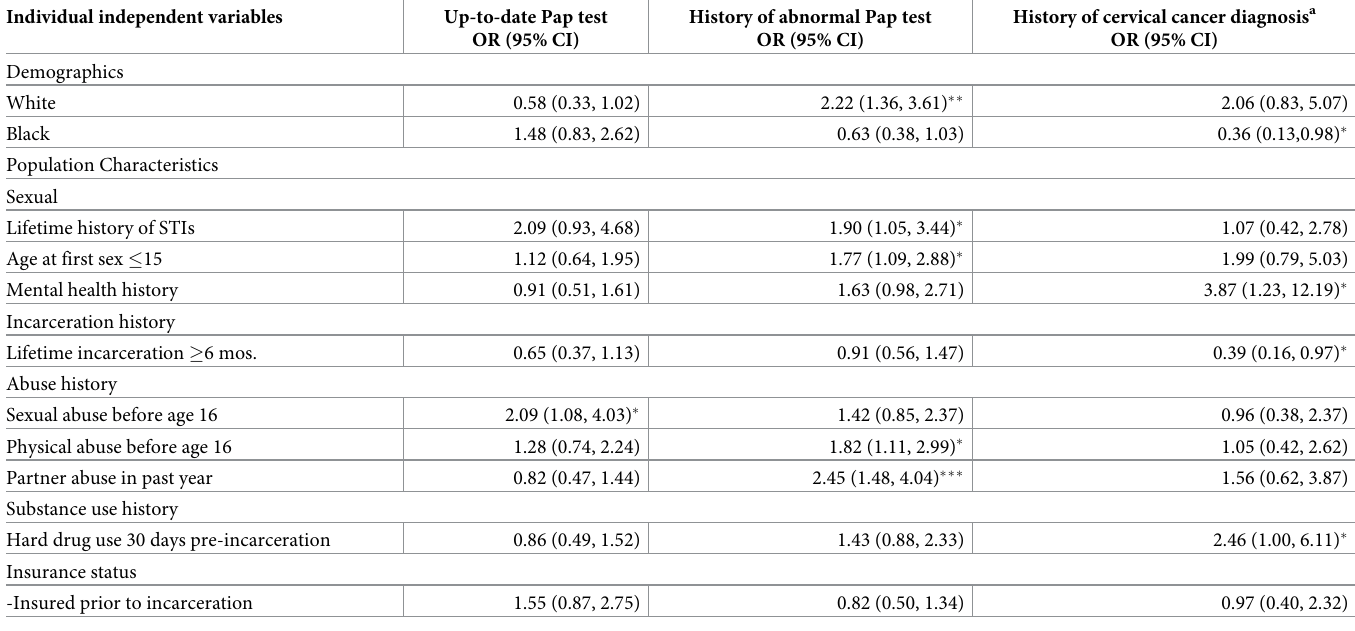
Table 3. Unadjusted odds ratios of variables with significant associations to cervical cancer screening outcomes, N = 290. Individual independent variables